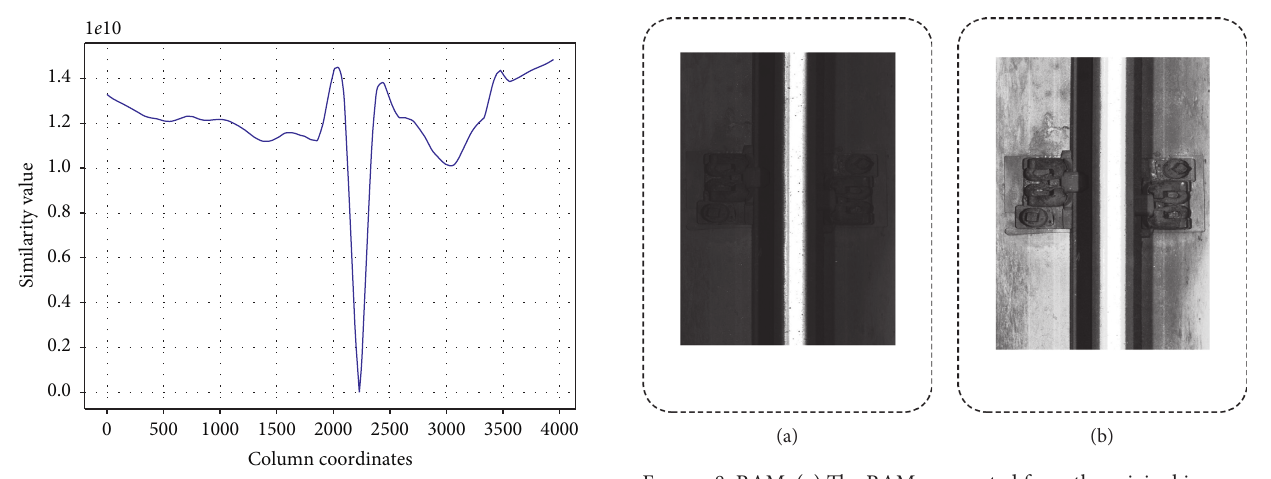
Figure 7: Similarity between the rail template and each subpicture.